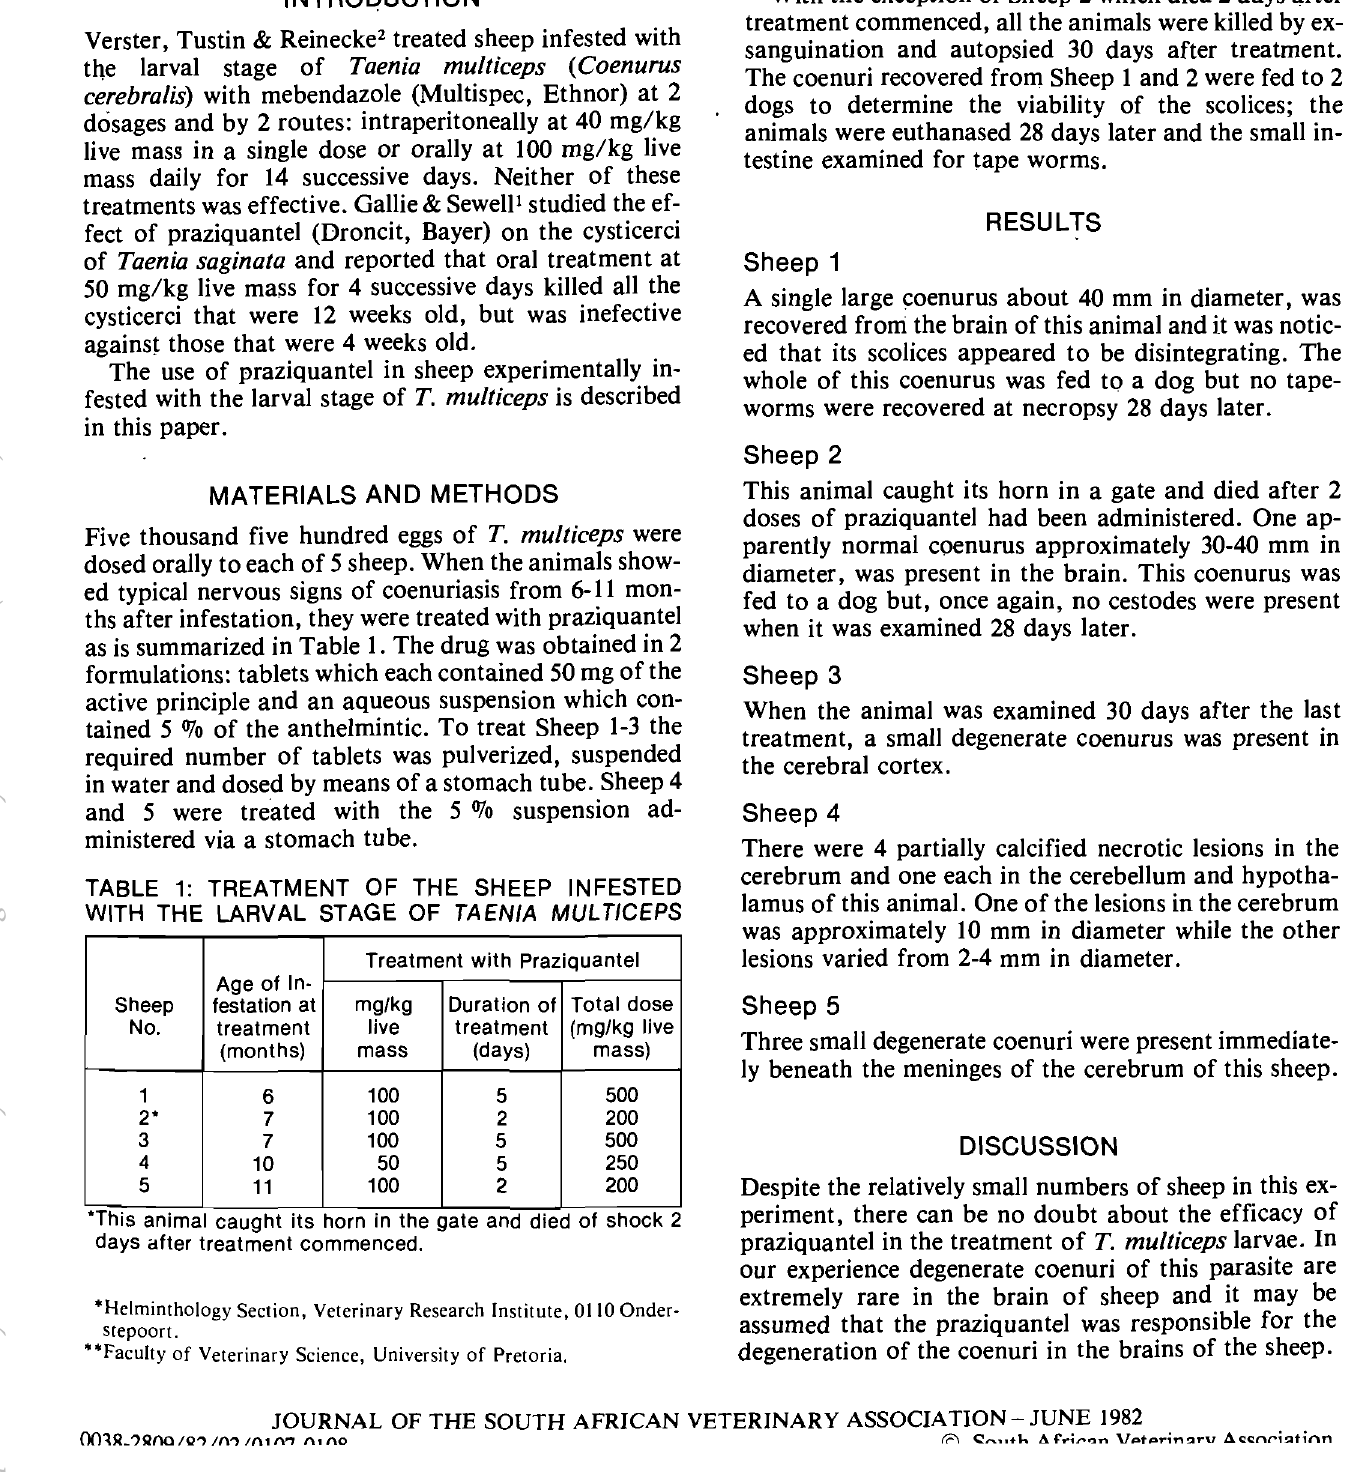
TABLE 1: TREATMENT OF THE SHEEP INFESTED WITH THE LARVAL STAGE OF TAENIA MULTICEPS Treatment with Praziquantel Age of